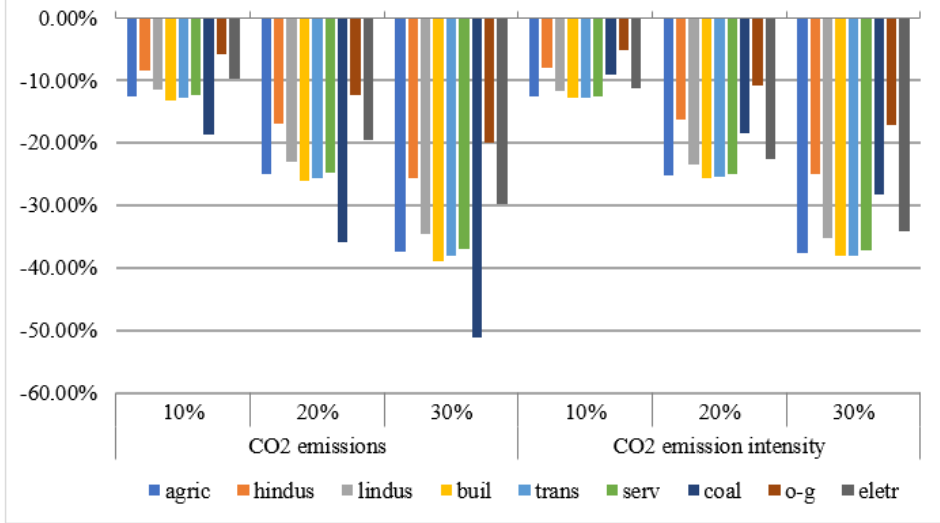
Figure 3. The sectors’ emissions and emissions intensity of carbon dioxide.